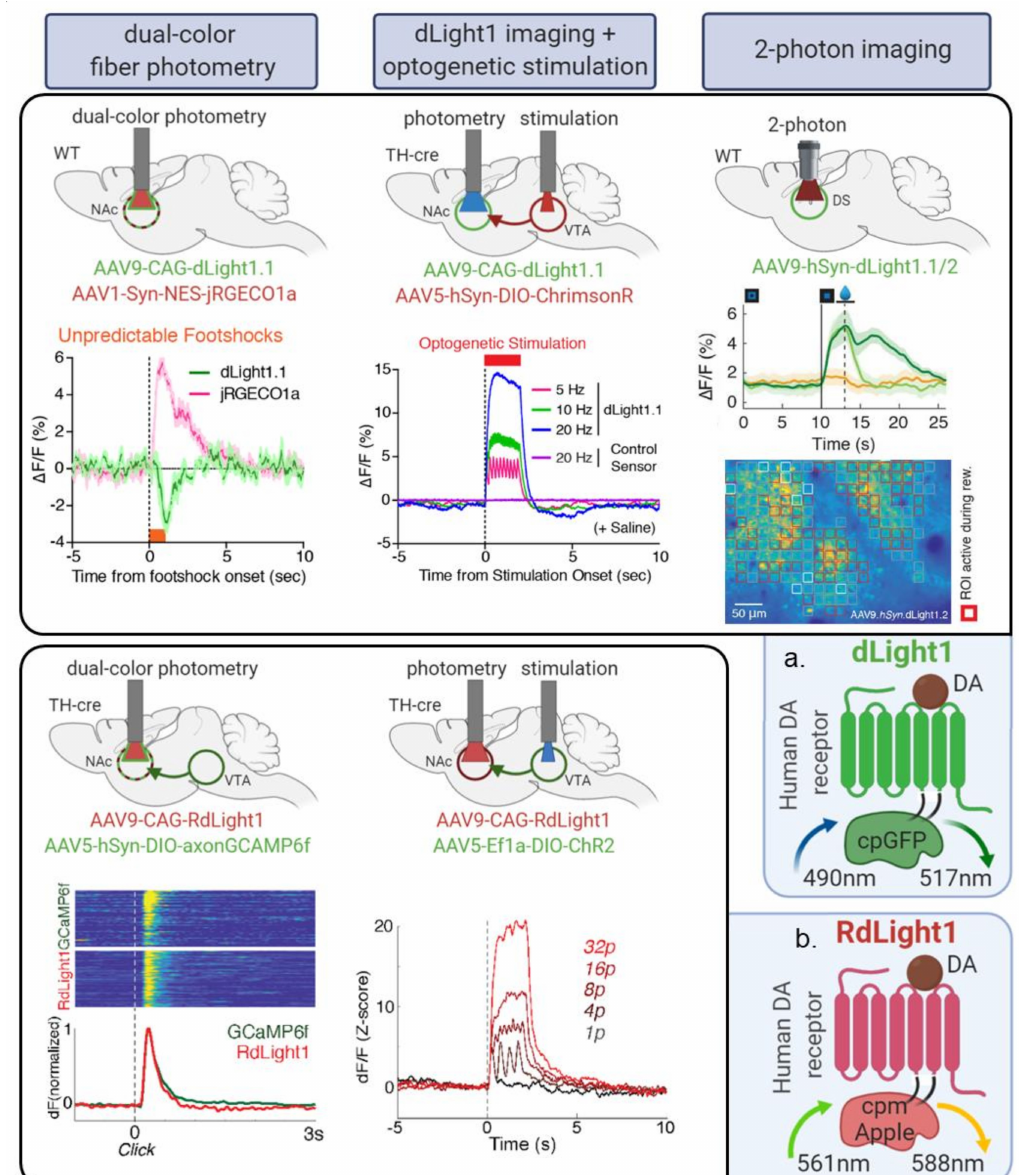
Figure 1. In vivo applications of dLight1 and RdLight1 dopamine (DA) sensors in mice. Graphs show normalized fluorescent responses (dFF). ( a ) dLight1 variants were validated in multiple imaging and experimental modalities: (i) dual-color fiber photometry of nucleus accumbens (NAc) cells using the red-shifted calcium sensor jRGECO1a [77] and local DA release using dLight1.1 following unpredictable shock exposure (dotted line); (ii) fiber photometry imaging of DA release using dLight1.1 in the NAc following optogenetic stimulation (5–20 Hz, 2 seconds) of DA cell bodies in the ventral tegmental area (VTA) using the red-shifted opsin ChrimsonR; (iii) two-photon imaging of DA release (dLight1.2) (top) across heterogeneous sites in motor cortex (M1 / M2) across 17 µ M large regions of interest ( = red square ROIs, bottom), here showing ROIs responsive to locomotion / reward expectation vs. rest (green vs. orange) at the Go cue (vertical line) and increases in fluorescence upon reward delivery (dark green) but not reward omission (light green) (population data) (middle). ( b ) RdLight1 validations: (i) dual-color fiber photometry of VTA terminals in the NAc using the green axon-targeted calcium sensor axon-GCaMP6f [52] and local DA release using RdLight1 following unexpected, audible reward deliveries (dotted line) and (ii) fiber photometry imaging of DA release using RdLight1 in the NAc following optogenetic stimulation (1–32 pulses; 2 seconds) of DA cell bodies in the VTA using the green opsin